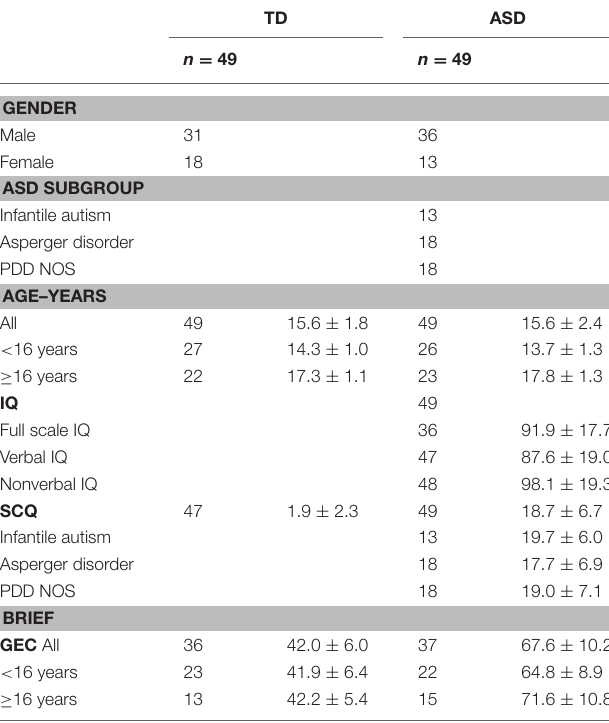
TABLE 1 | Demographics; number ( n ) and mean ± SD